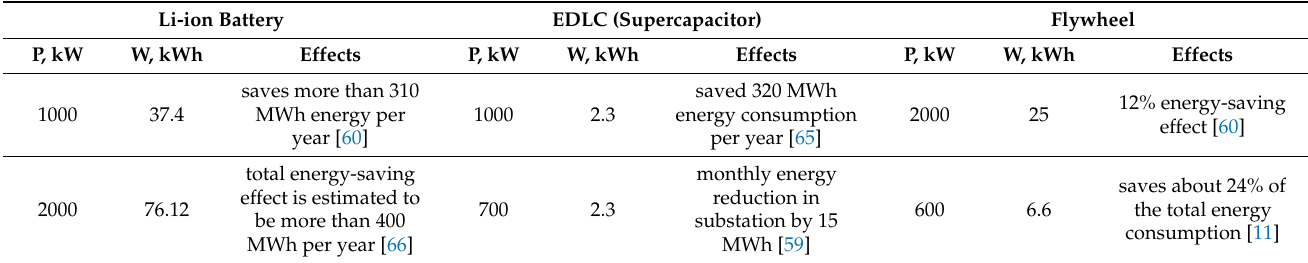
Table 3. Examples of ESS using for regenerative braking.